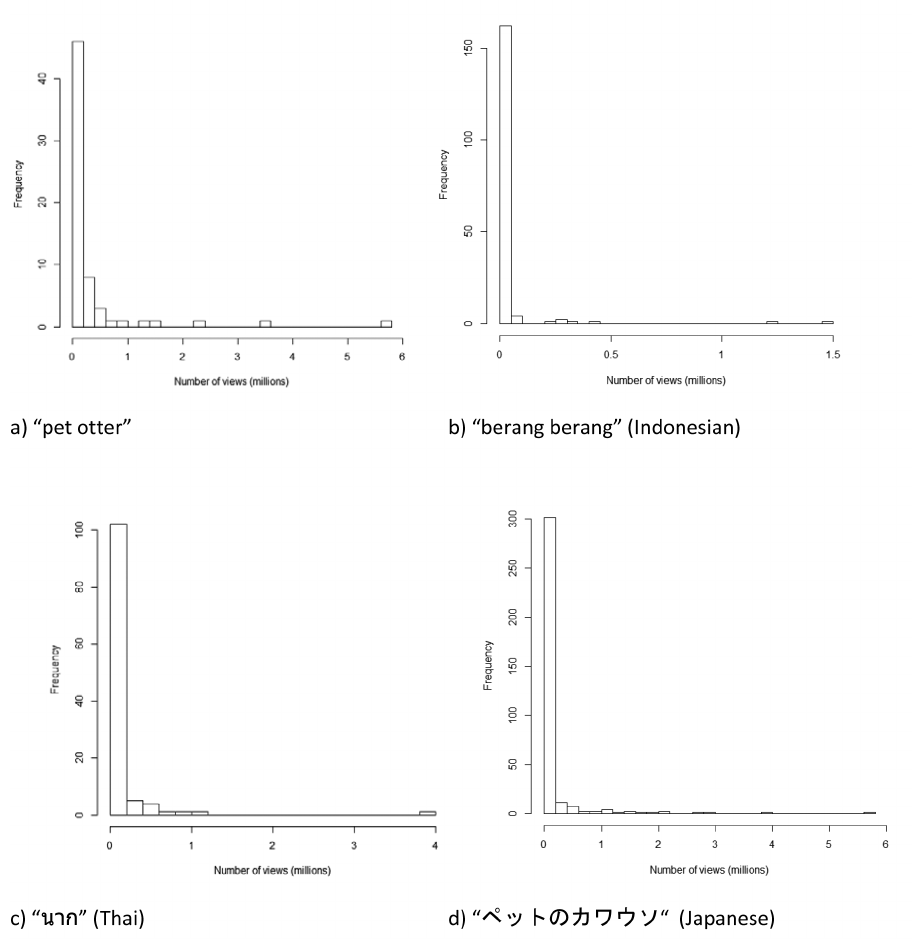
Figure A1. Total number of